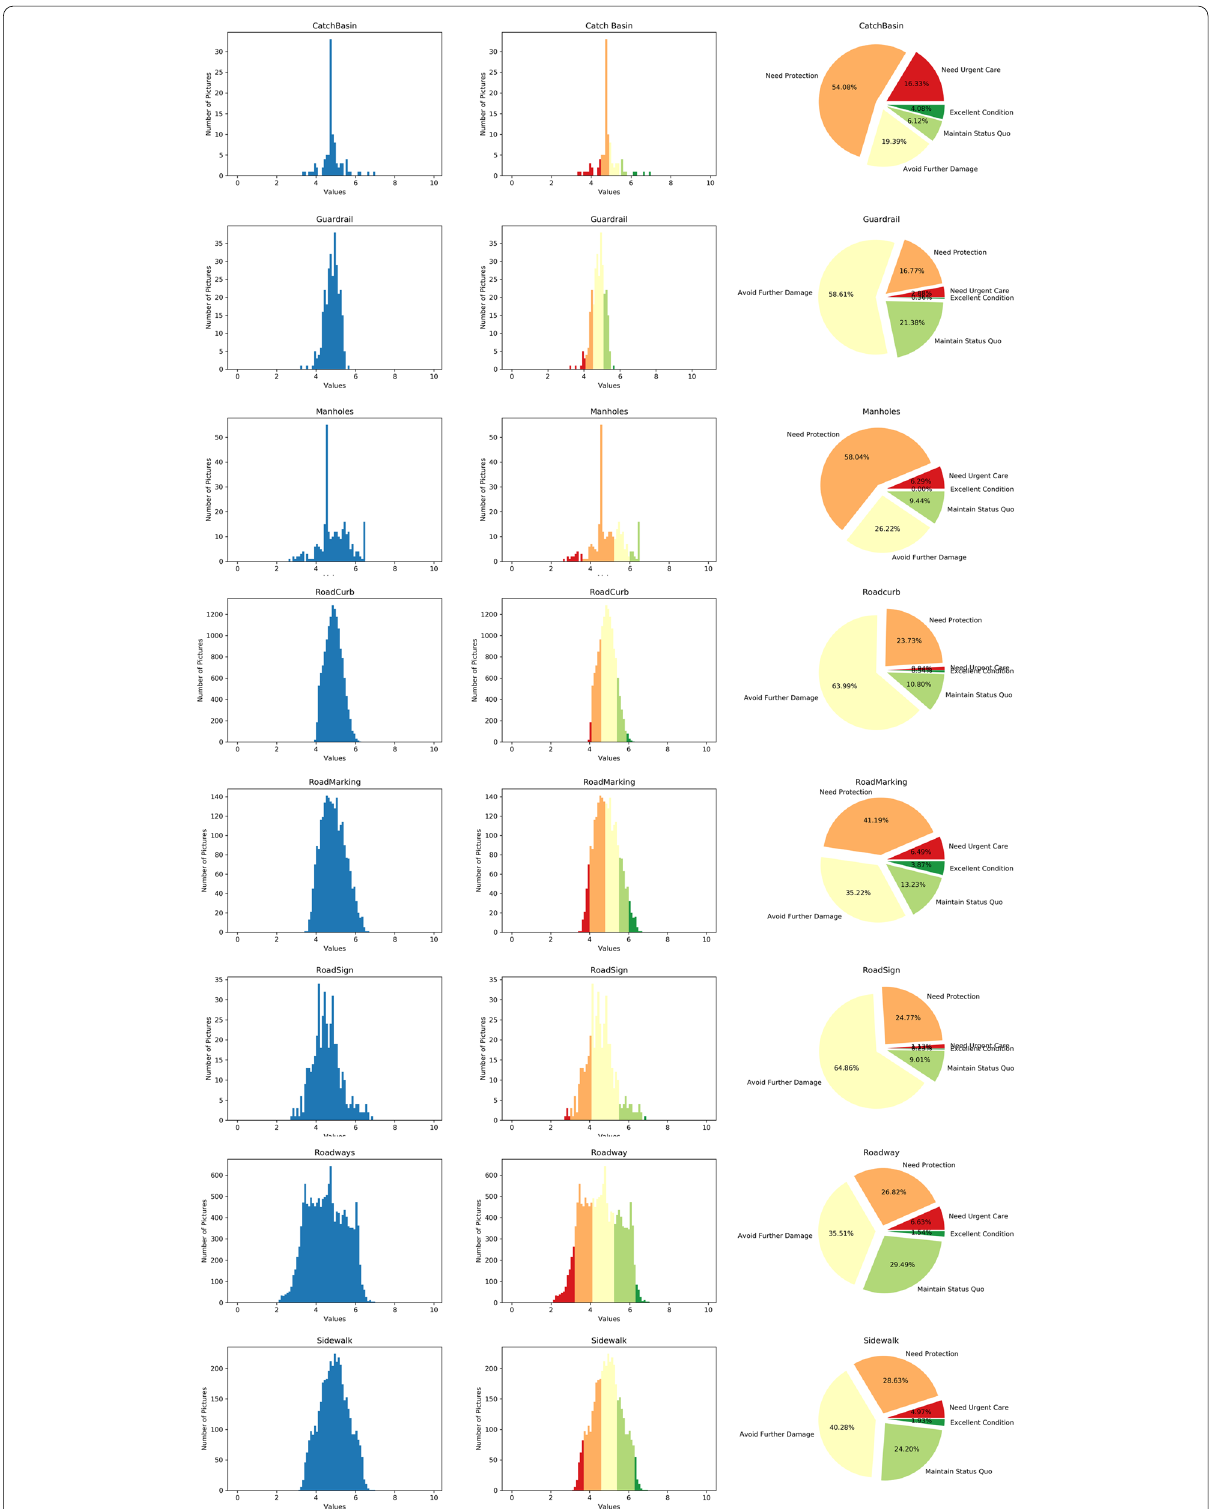
Fig. 28 The evaluation results of different facilities and the ratio of their 5 maintenance